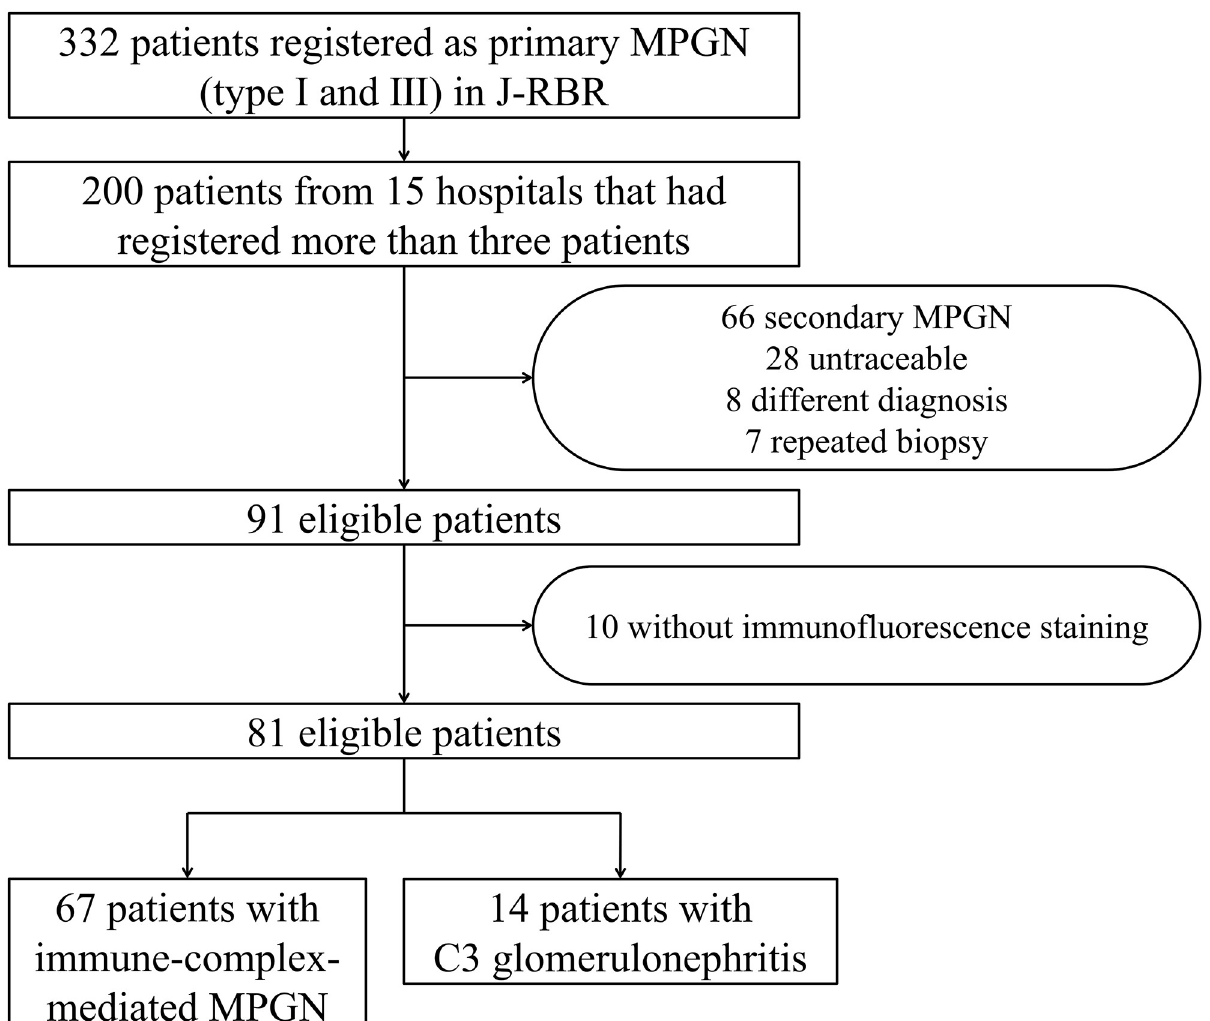
Fig 1. Flow chart showing enrollment of 81 patients. MPGN, membranoproliferative glomerulonephritis; J-RBR, Japan Renal Biopsy Registry.